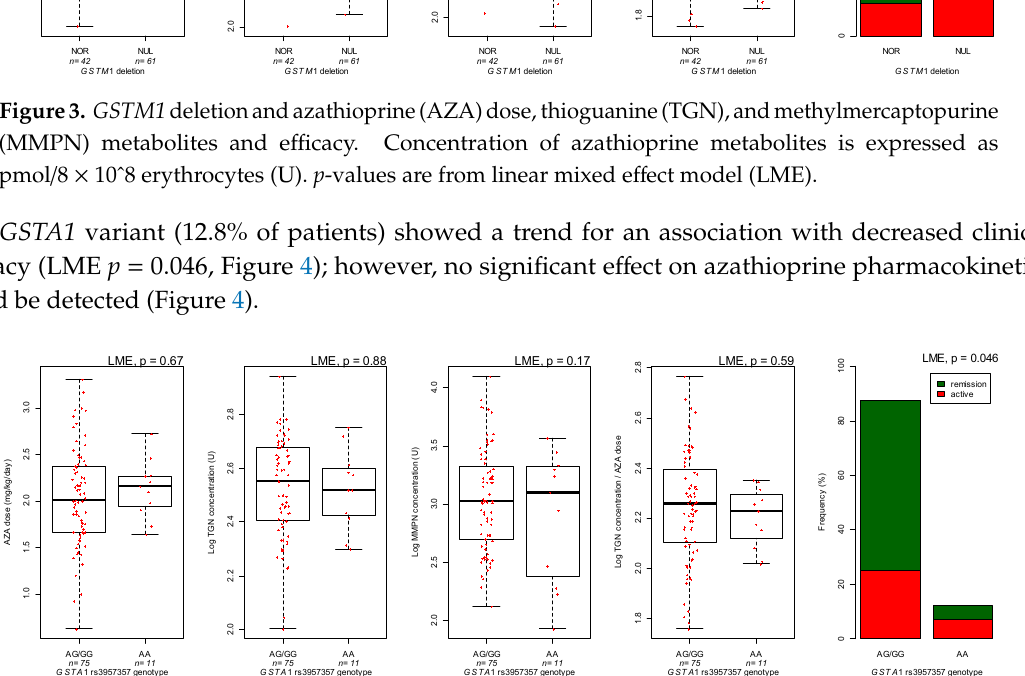
Figure 4. GSTA1 rs3957357 variant and azathioprine (AZA) dose, thioguanine (TGN) and methylmercaptopurine (MMPN) metabolites and efficacy. Concentration of azathioprine metabolites is expressed as pmol/8 × 10^8 erythrocytes (U). P- values are from linear mixed effect model (LME). GSTT1 deletion was not associated with azathioprine pharmacokinetics and efficacy (data not shown). Multivariate analysis supported the results of the univariate analysis (Table 5).